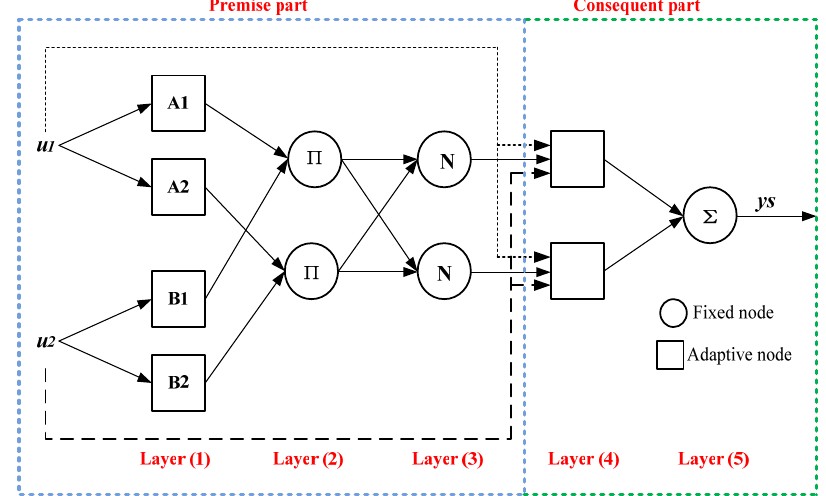
Figure 1. The two inputs adaptive neuro-fuzzy inference system (ANFIS) model architecture (A and B are a membership functions